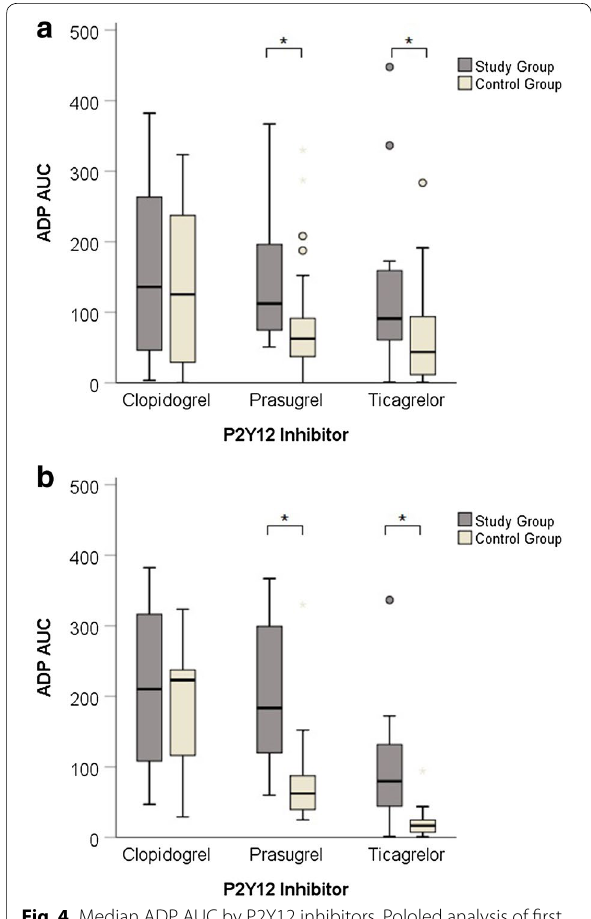
Fig. 4 Median ADP AUC by P2Y12 inhibitors. Pololed analysis of first three days ( a ) and day 3 alone ( b )